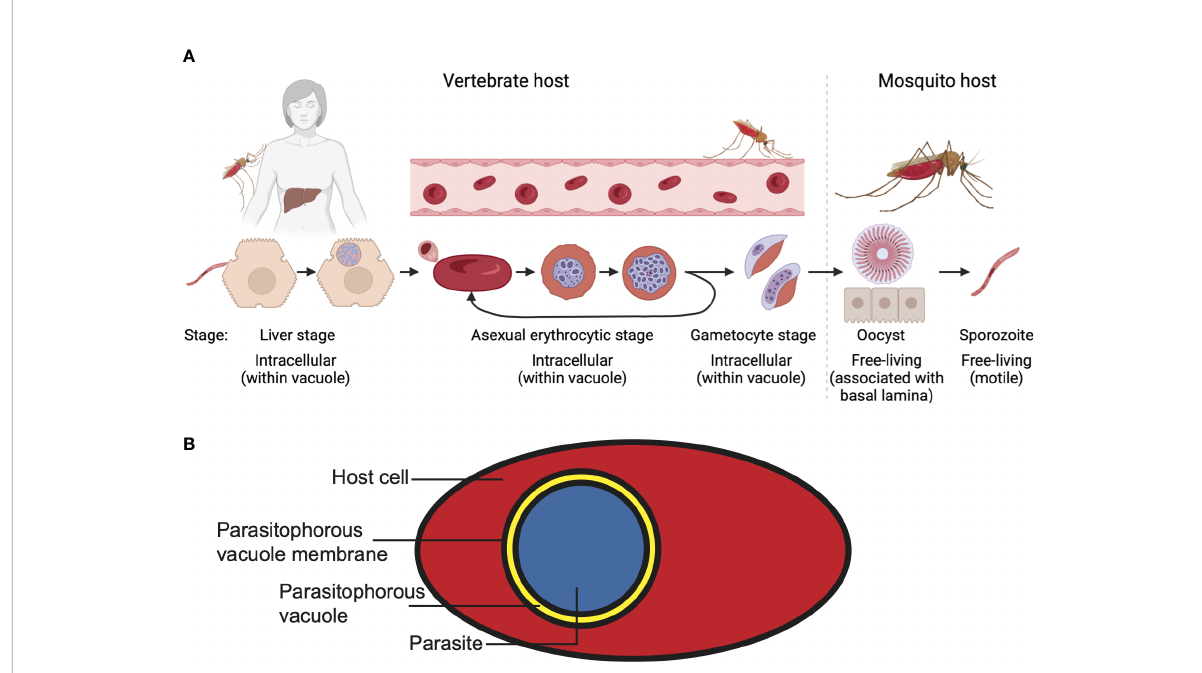
FIGURE 1 Plasmodium falciparum lifecycle. (A) For the different stages, the location of the parasite with regards to the host and host cells is indicated. Note the different lifestyles of the parasites. (B) A malaria parasite within a parasitophorous vacuole in a host cell. Shown here is an infected